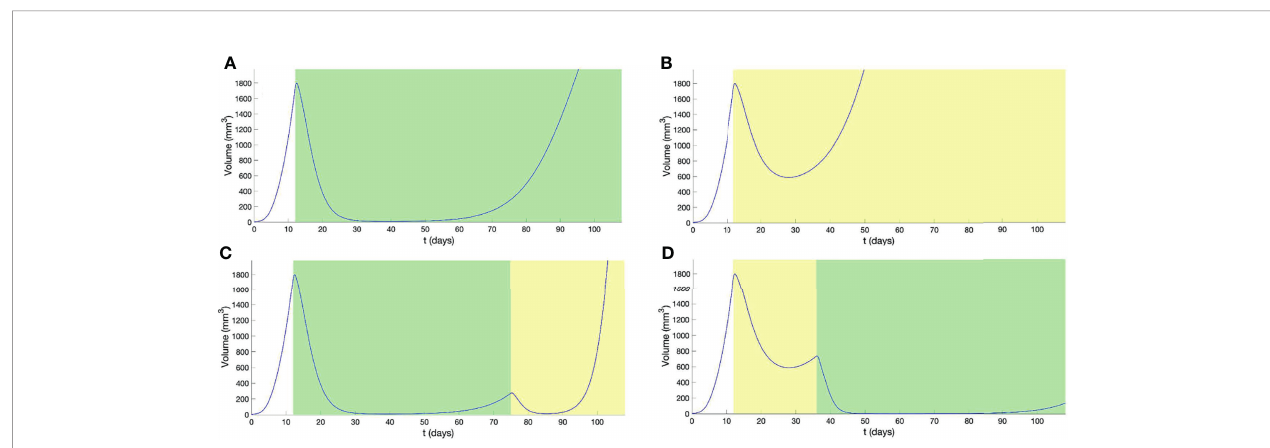
FIGURE 2 | Outcomes from combination therapy, with treatment intervals indicated by graphical shading for BRAF/MEKi ( green ) and HCT ( yellow ). Panels show the outcomes from (A) continuous BRAF/MEKi, (B) continuous HCT, (C) combination BRAF/MEKi then HCT, and (D) combination HCT then BRAF/MEKi treatment